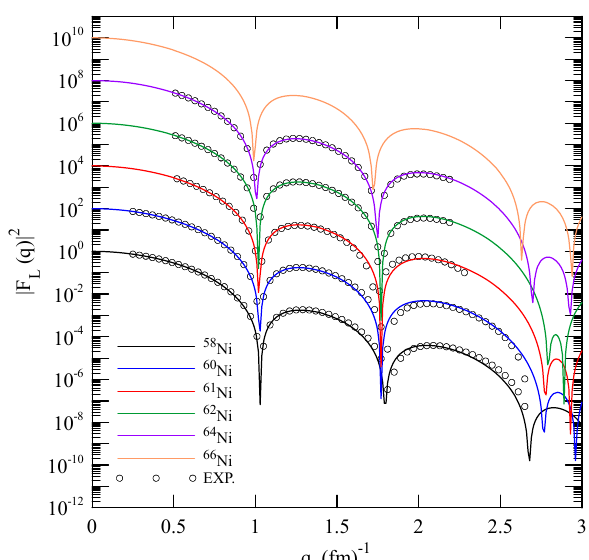
Fig. 6: The charge form factors calculated with SKM* parameterization for 58 Ni, 60 Ni ( (cid:3400) 10 2 ), 61 Ni ( (cid:3400) 10 4 ), 62 Ni ( (cid:3400) 10 6 ), 64 Ni ( (cid:3400) 10 8 ) and 66 Ni ( (cid:3400) 10 10 ). The experimental data are taken from Ref.